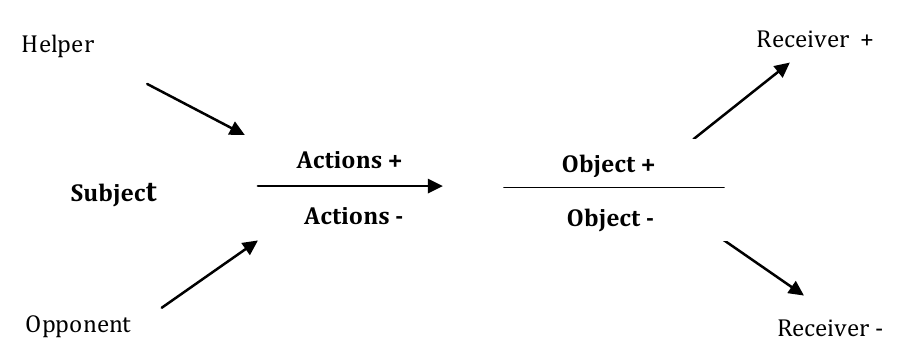
Figure 4 . The “actantial schema” in its fullest form (Piret et al., 1996, p.